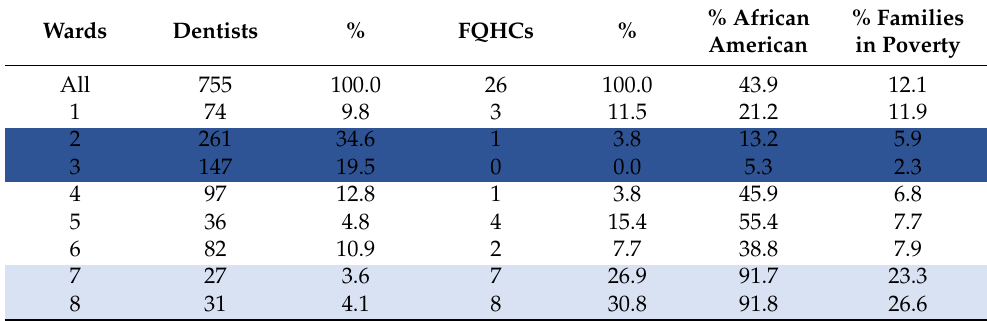
Table 1. Dental Services by Ward, Washington DC.